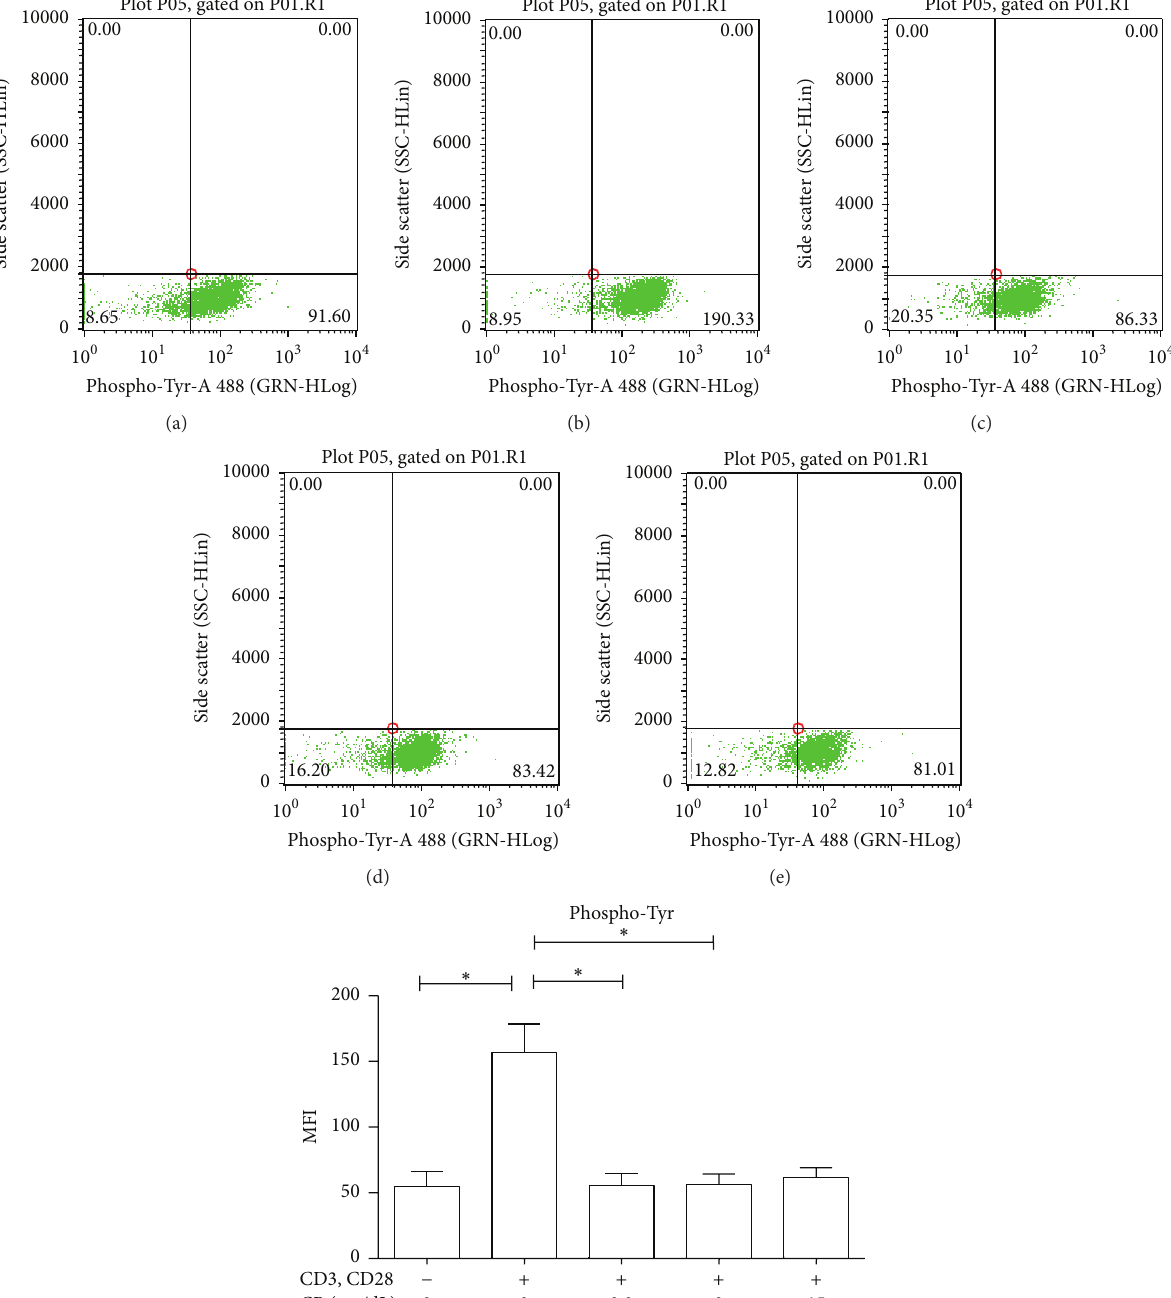
Plot P05, gated on P01.R1